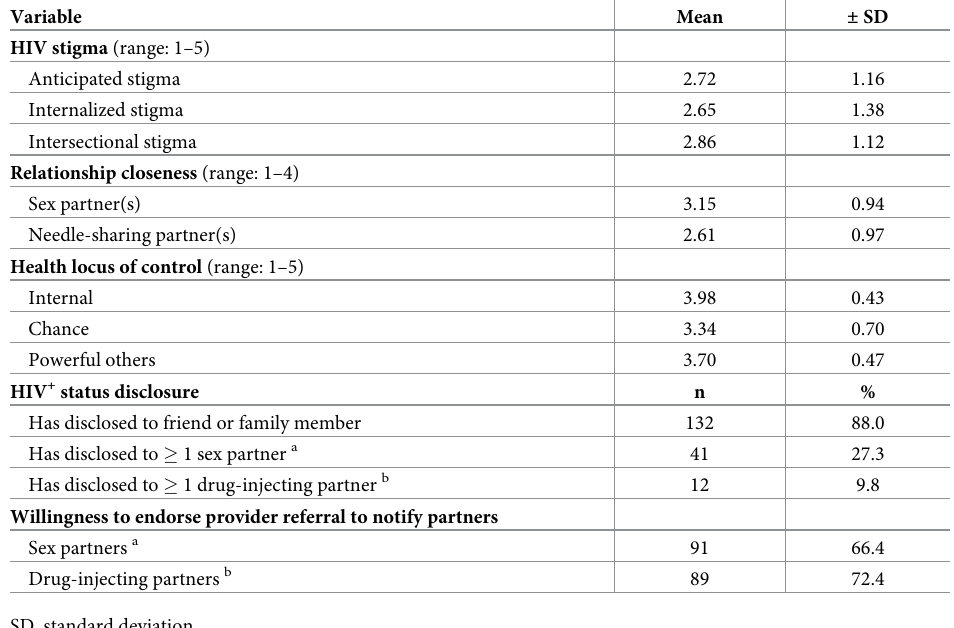
Table 3. Psychosocial factors and willingness to endorse provider referral (n =